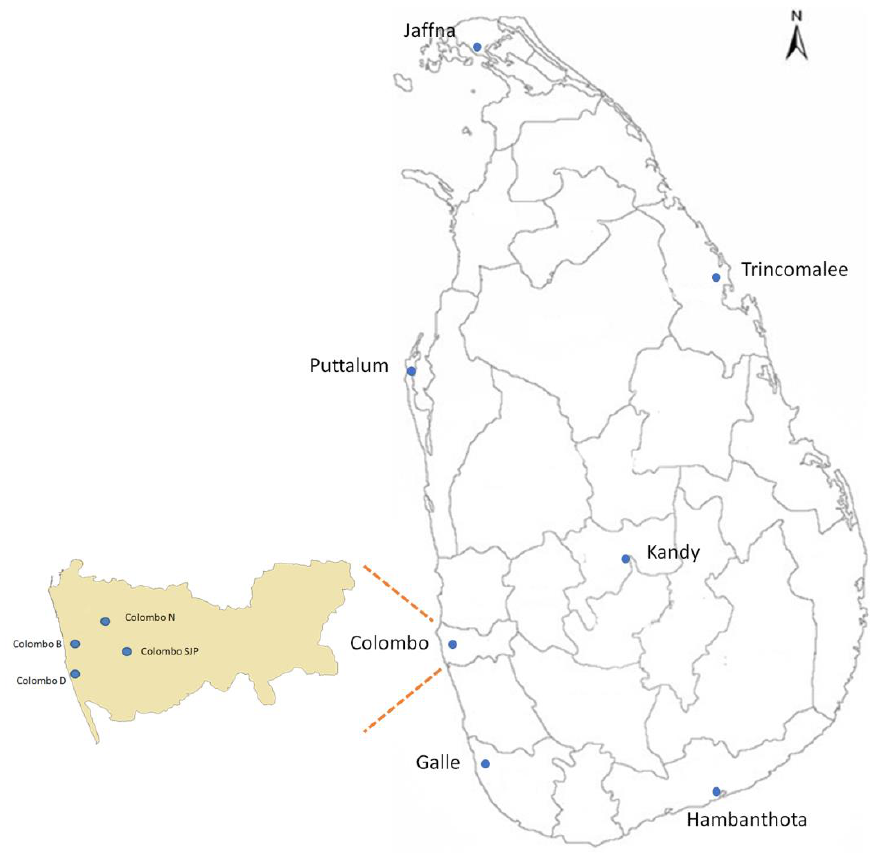
Figure 1. Location of Ae. aegypti collection sites in Sri Lanka. Blue dots indicate the sampling sites and light gray lines indicate the district boundaries on the map.